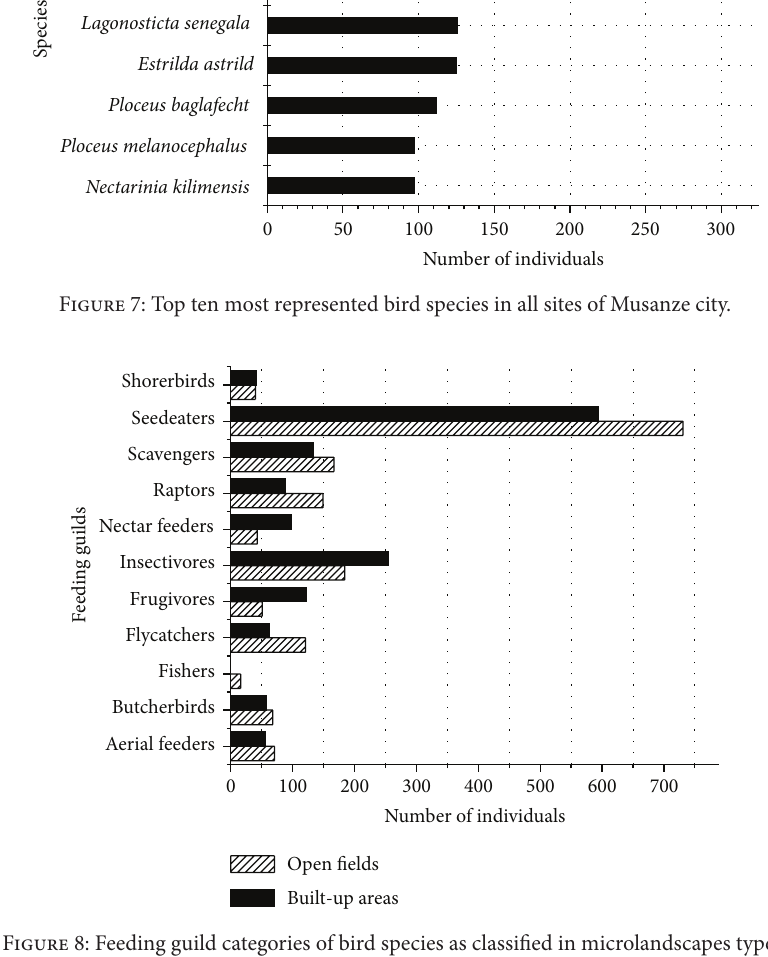
Figure 8: Feeding guild categories of bird species as classified in microlandscapes